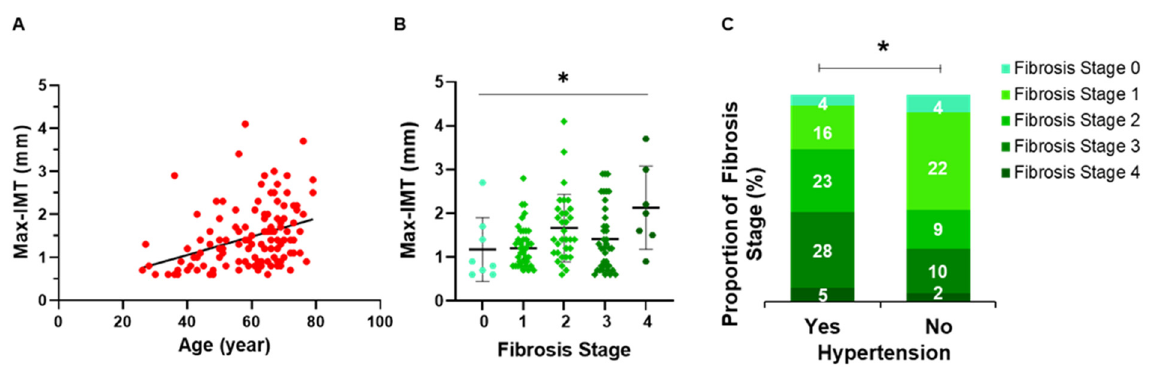
Figure 4. Association among age, liver fibrosis, and Max-IMT. ( A ) Correlation between age and Max-IMT. ( B ) Max-IMT at each hepatic fibrosis stage. The middle bar represents the median and the upper/lower bars represent the 95% confidence interval. ( C ) Association between hypertension and hepatic fibrosis stage. * p < 0.05. Max-IMT, maximum intima–media thickness.